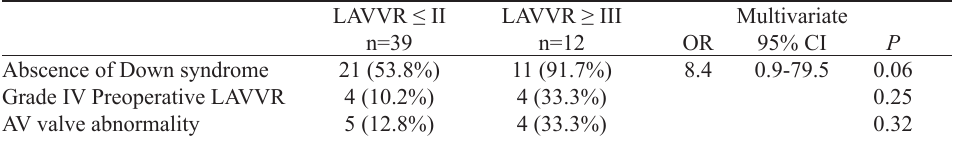
Table 4. Multivariate relations between variables and moderate or severe postoperative left atrioventricular valve regurgitation